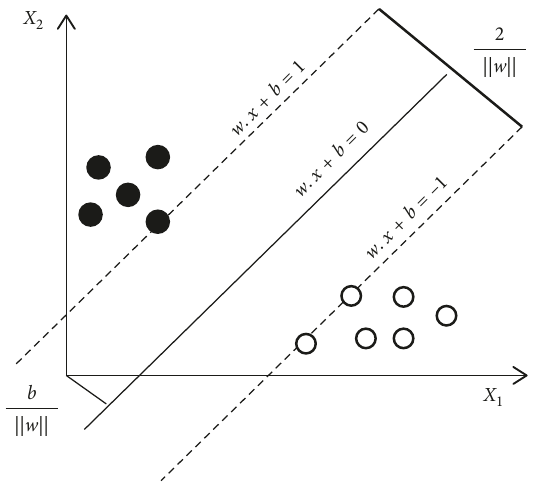
Figure 8: Linear Support Vector Machine